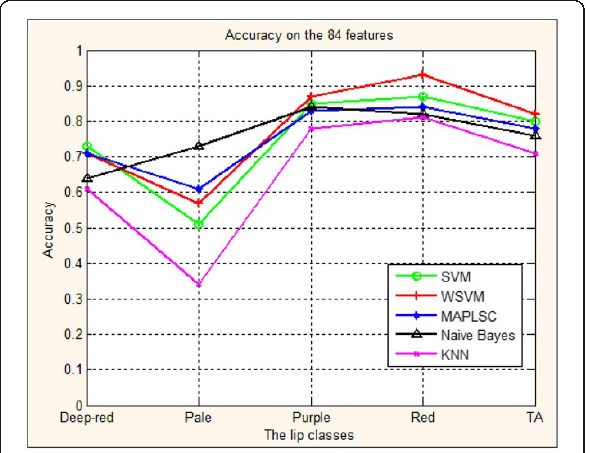
Figure 7 Prediction accuracy of lip image classification using SVM, WSVM, MAPLSC, Naïve Bayes and kNN on all the 84